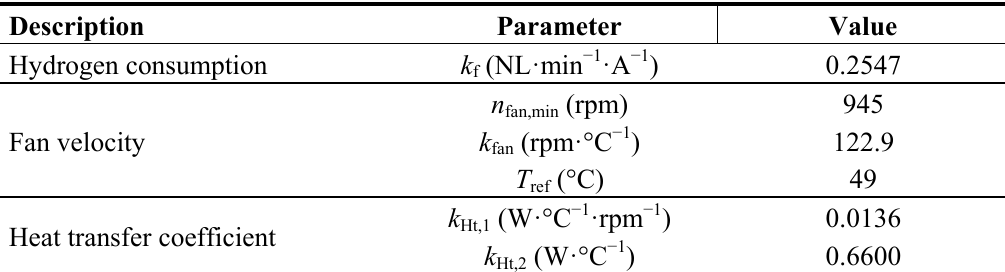
Table 2. Parameters for the thermal